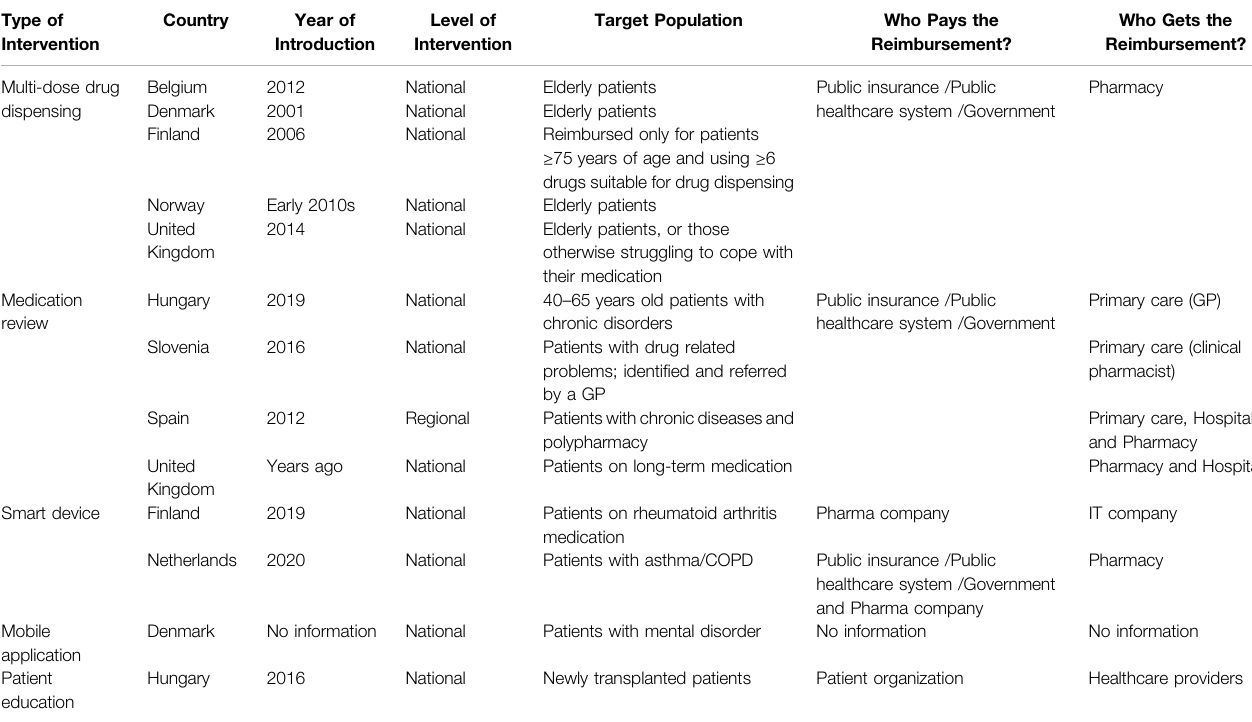
TABLE 2 | Characteristics of identi fi ed reimbursed medication adherence enhancing interventions. Type of